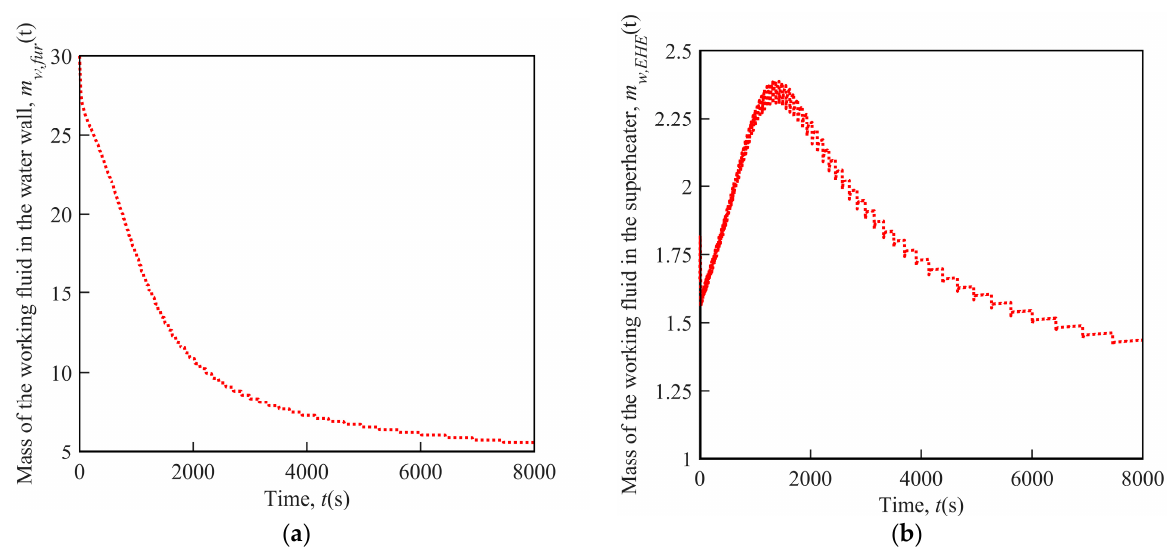
Figure 7. Variation of fluid mass under sudden electricity failure: ( a ) Water wall; ( b ) superheater.